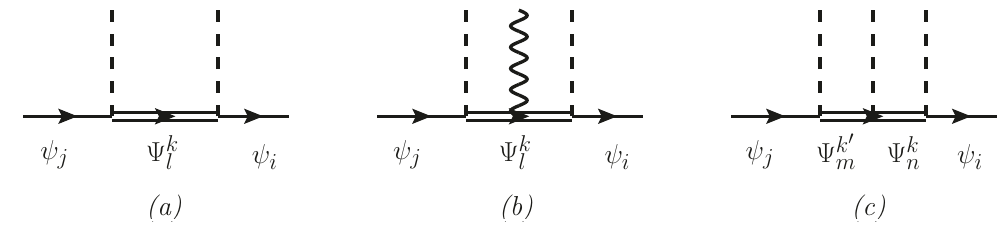
Figure 10 . Three types of diagrams generating NP induced ( v 2 =M 2 ) (cid:13)avor violating transitions O among the SM fermions (single lines) from tree level exchanges of gears (double lines). The dashed lines denote the SM Higgs, while the wiggly line in diagram (b) denotes either a W or Z boson. keep in the analysis terms that are leading in the Y U;D v=M